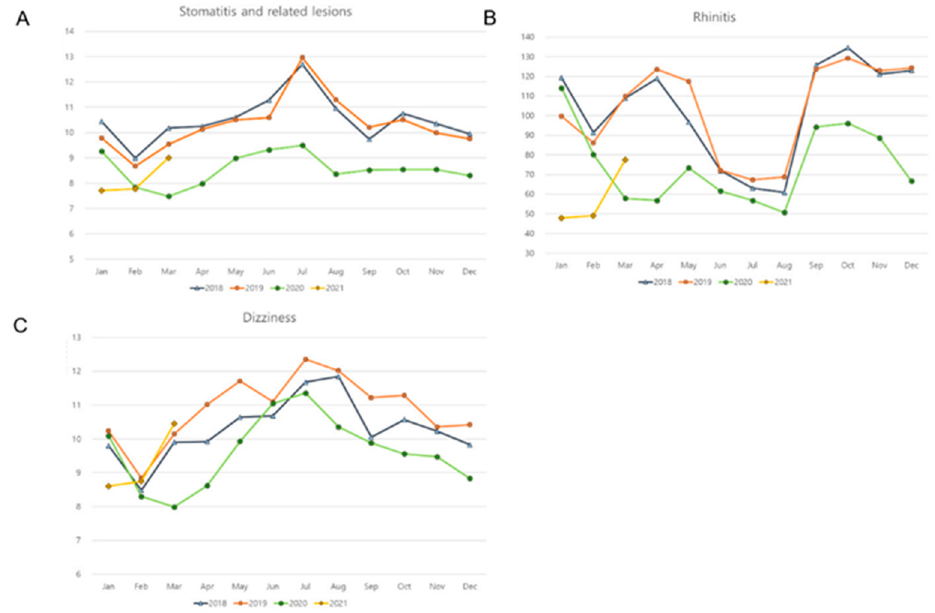
Figure 2. Monthly incidences of ( A ) stomatitis and related lesions, ( B ) rhinitis, and ( C ) dizziness. (y-axis: x 10,000 person)